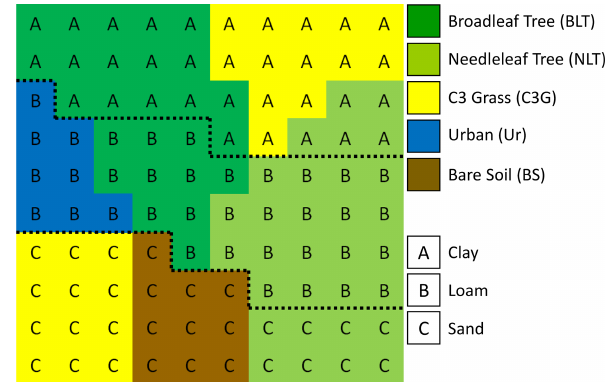
Figure 1. Synthetic grid box used to define and test the new soil tiling configurations. This consists of a 10-by-10-pixel grid, each with one of five different surface types and one of three soil types. The surface types correspond to broadleaf tree (BLT, dark green), needleleaf tree (NLT, light green), C3 grass (C3G, yellow), urban (Ur, blue) and bare soil (BS, brown). The three soil types are clay (A), loam (B) and sand (C) as defined by Cosby et al. (1984).